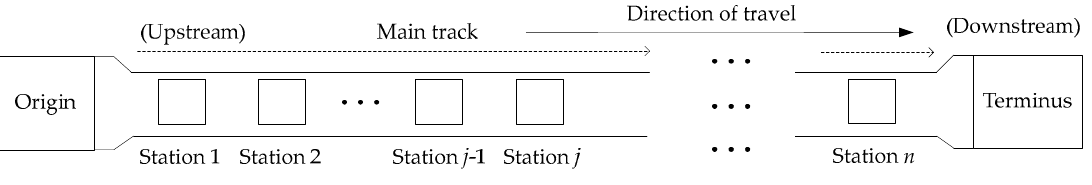
Figure 2. Train operation illustration of a metro line.